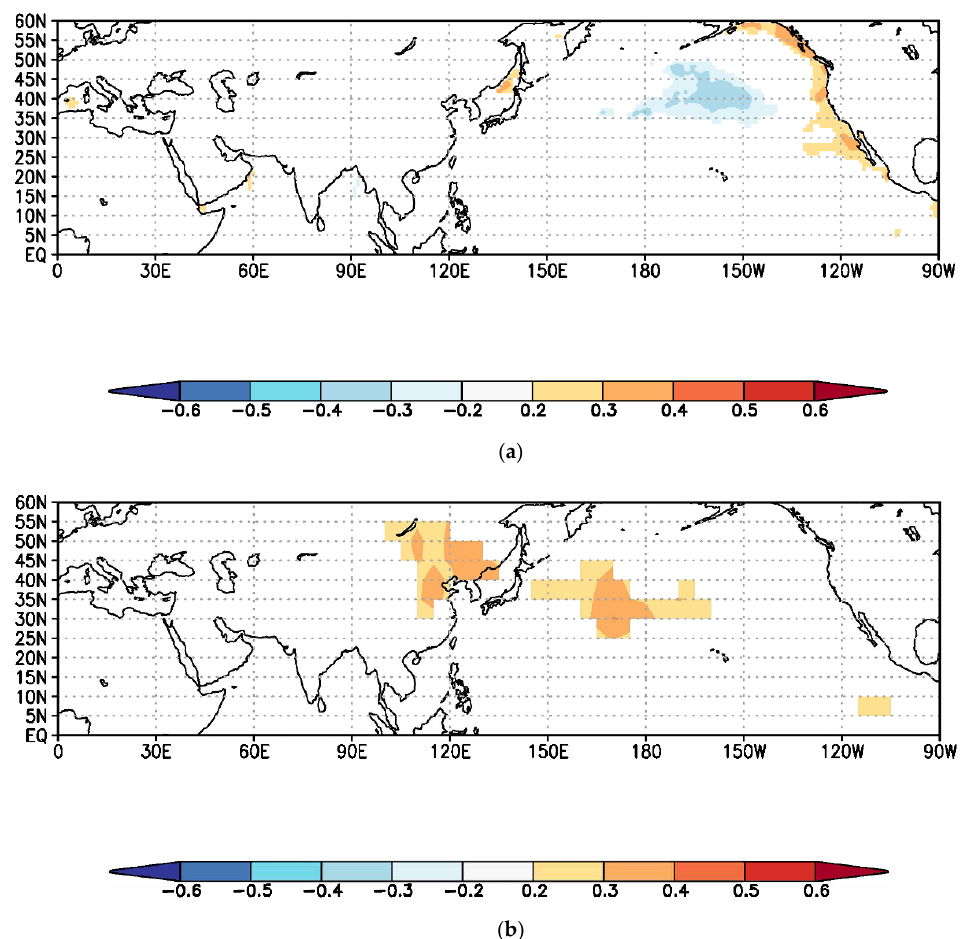
Figure 2. ( a ) Rank correlation analysis between AMFP and JFM SSTa ( a ), JJA SLPa ( b ). The blue SSTa region and orange SLPa regions have significant negative and positive correlation with AMFP, respectively, at 90% confidence interval (i.e., p <